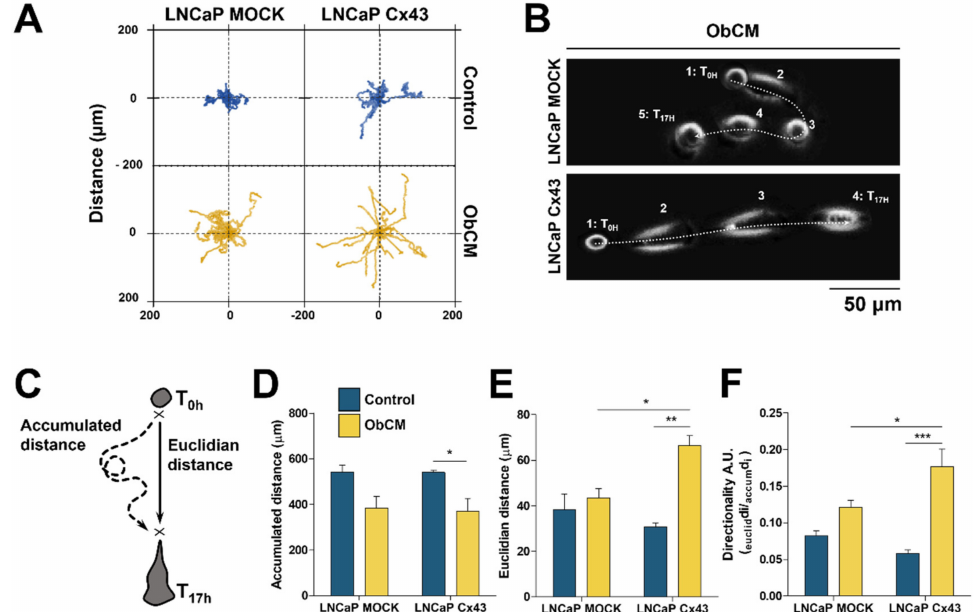
Figure 3. Cx43 induces osteoblasts-dependent migration of LNCaP cells. Quantitative analysis of single cell migration of LNCaP using time-lapse videomicroscopy. Cells were incubated for 17 h with either control or osteoblasts-conditioned media (ObCM), and records were used for manual tracking of cell centroid trajectories. ( A ) Scaled spider graph showing for each condition the individual paths of 15 representative cells starting from their initial position at T = 0. ( B ) Overlapped phase contrast images showing the shape and the trajectory over time of representative LNCaP MOCK and Cx43 cells upon ObCM stimulation. ( C ) Three dynamic parameters were quantified, the total path length, referred to as accumulated distance ( µ m) ( D ) the straight distance between the starting and ending point of the trajectory referred to as ‘Euclidian distance’ ( µ m) ( E ) and the directionality defined by the accumulated distance divided by the Euclidian distance ( F ). Data represent the mean ± SEM from 4 di ff erent experiments (MOCK CTRL n = 167; MOCK ObCM n = 179; Cx43 CTRL n = 171; Cx43 ObCM n = 166). * p < 0.05; ** p < 0.01; *** p <